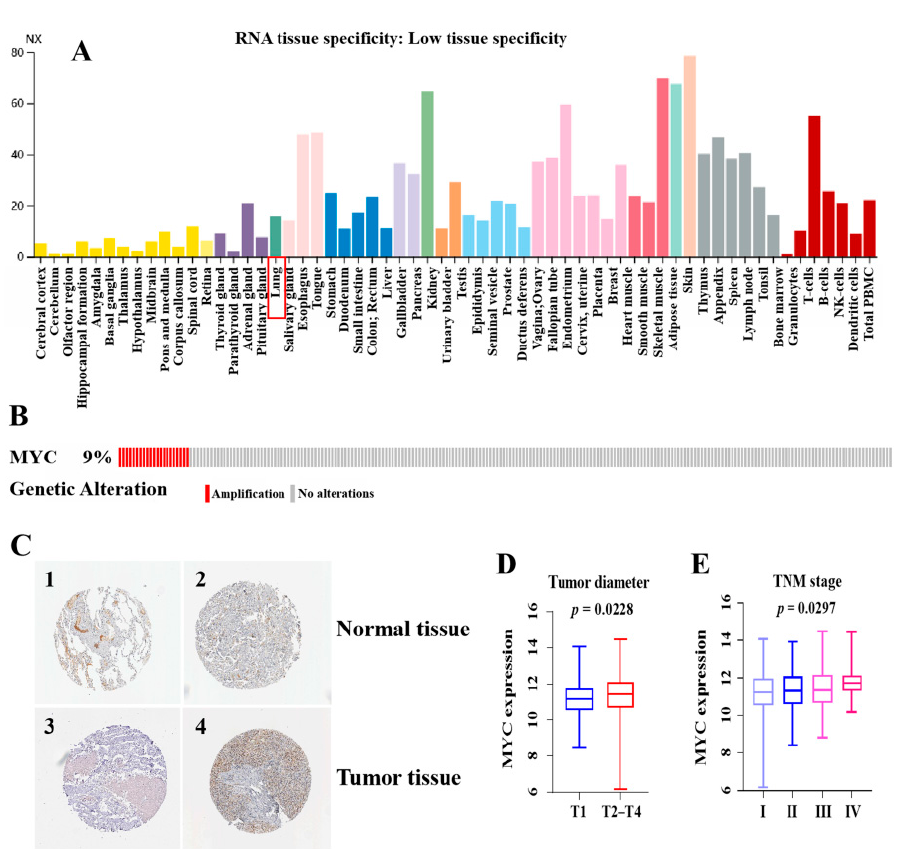
Figure 1. High expression of c-Myc in LUAD and prognostic value. ( A ) c-Myc expression distribution in all tissues. ( B ) The distribution of c-Myc genomic alterations in TCGA LUAD is shown on cBioPortal OncoPrint plots. ( C ) Validation of c-Myc expression at the translational level by the HPA database, normal tissue (1 and 2), and tumor tissue (3 and 4). ( D ) Correlation analysis of c-Myc expression values with tumor size (T1 ≤ 3 cm, T2–T4 > 3 cm). ( E ) Correlation analysis of c-Myc expression values with TNM stage. The RNAs expression value was logarithmized with log2. p < 0.05 was deemed as statistically